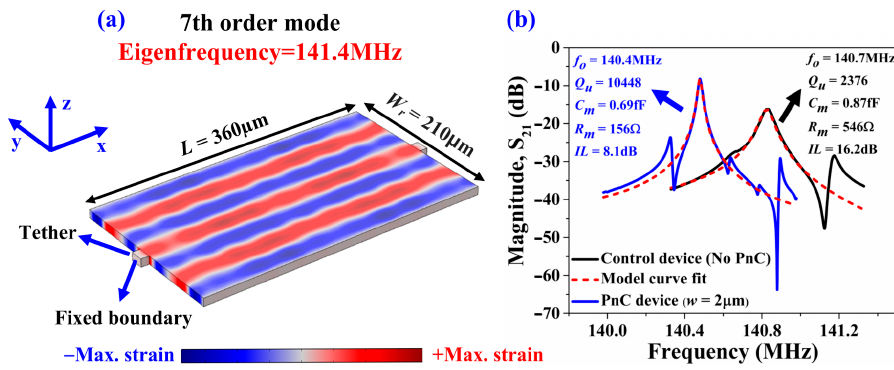
Figure 6. ( a ) FE simulation of the 7th-order symmetric Lamb mode where the contours denote the associated y-direction strain component. ( b ) Typical measurements of the transmission S 21 of two of the partially covered resonators with three IDT fingers with PnC anchors ( w = 2 μ m) and a control device (no PnC anchors) for comparison to illustrate the increase in Q; the resonators were transduced in the 7th-order symmetric Lamb